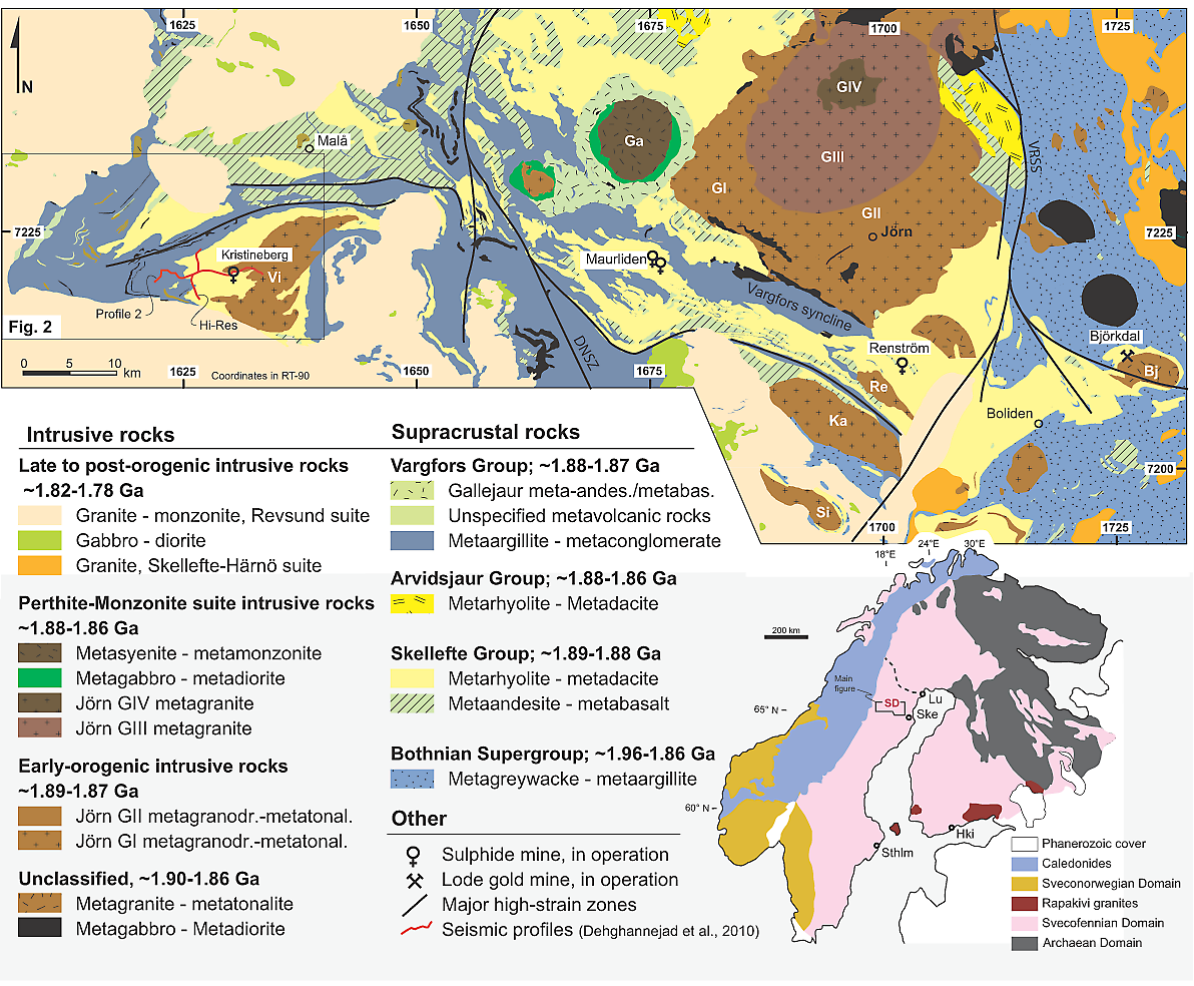
Fig. 1. Inset: generalized Fennoscandian Shield geology. Main map: geological overview of the Skellefte district, as loosely defined by the occurrence of the Skellefte Group metavolcanic rocks, and their immediate vicinity. DNSZ: Deppis–Näsliden shear zone; VRSS: Vidsel- Röjnöret shear system. Intrusions: Bj: Björkliden, Ga: Gallejaur, Ka: Karsträsk, Re: Rengård, Si: Sikträsk, Vi: Viterliden, and GI, GII, GIII, GIV: Jörn-type intrusions, phases I–IV. Geology after Kathol et al. (2005) and Bergman Weihed